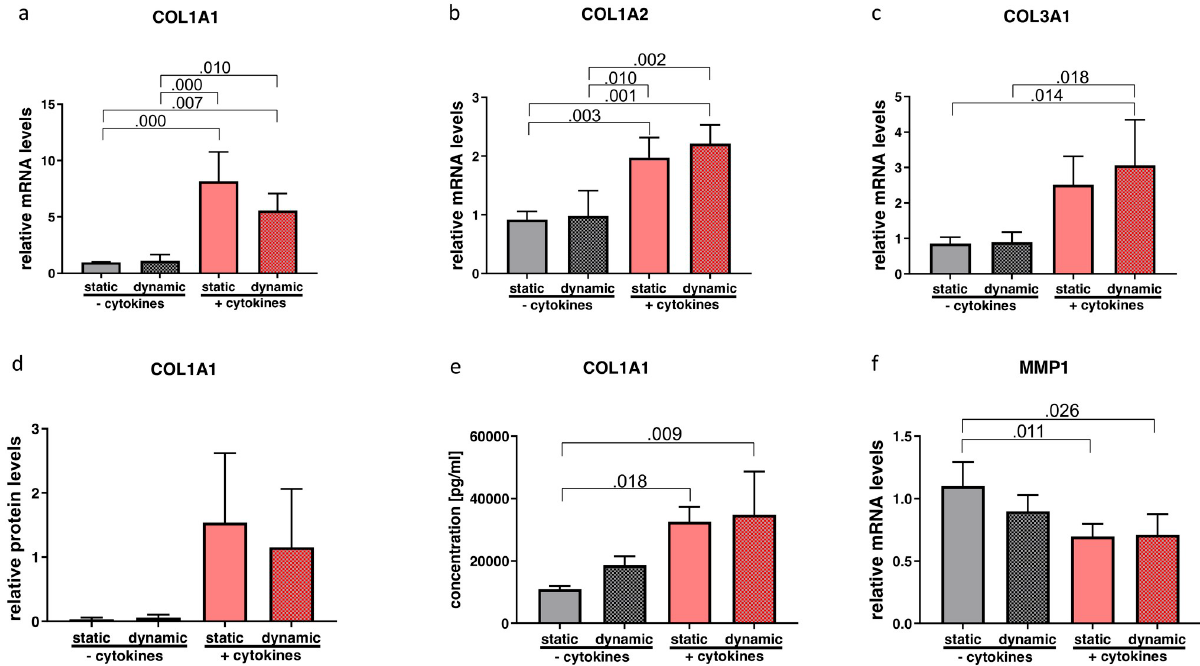
Fig 4. Effect of cytokine treatment and/or vibration on ECM-related molecules. mRNA (a-c and f) and protein levels (d and e) of ECM-related molecules were analyzed by RT-qPCR, Western blot and Luminex, respectively. Results are represented as mean ± S.D. of four independent experiments (N = 4). Statistical analysis was performed using one-way ANOVA (normally distributed data) or Kruskal-Wallis test (non-parametric data), p < 0.05 was considered significant; decimal numbers above the bars represent the statistically significant p-values from post-hoc comparisons. For the p-values not presented here, see S2 File. COL1A1 (collagen 1 alpha 1), COL1A2 (collagen 1 alpha 2), COL3A1 (collagen 3 alpha 1), MMP1 (matrix metalloproteinase 1).